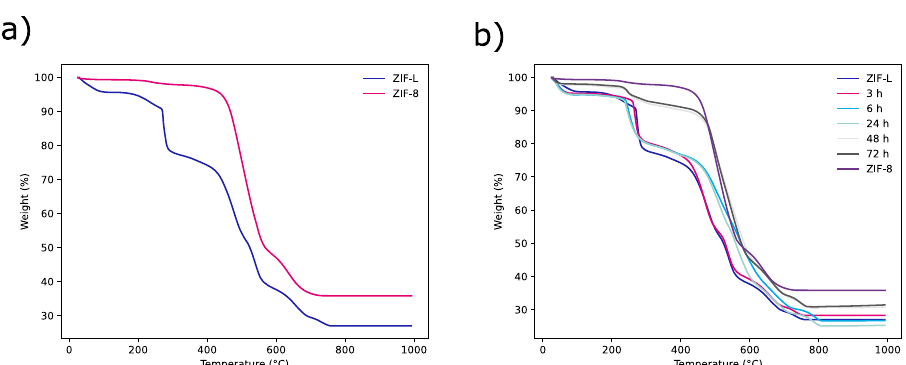
Fig. 5 TGA data collected on samples obtained during the transformation. TGA (in air) traces for a ZIF-L and ZIF-8 and b samples subjected to washing.